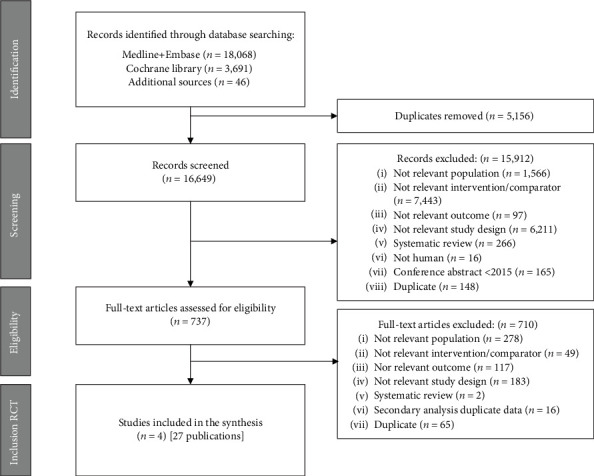
PRISMA flow chart.